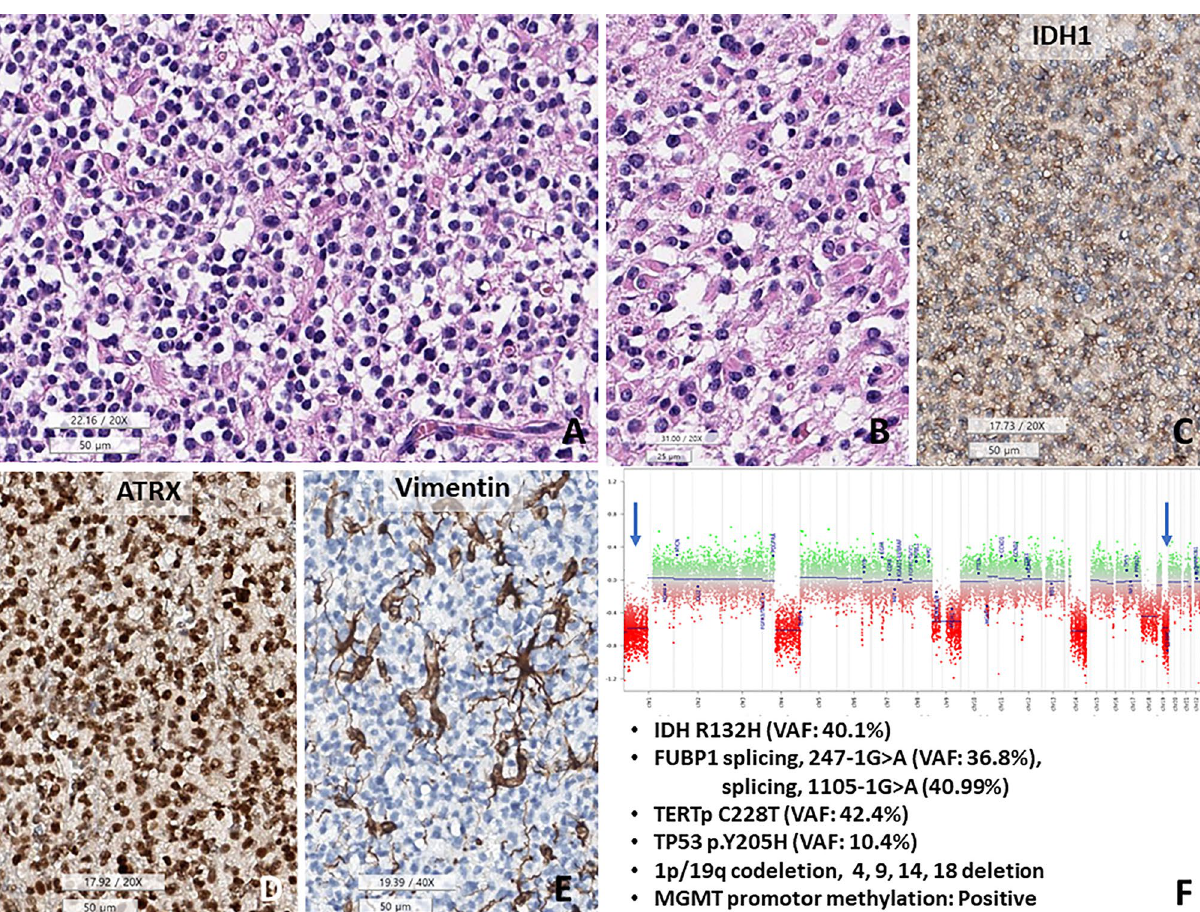
Figure 2. TP53 -mutant oligodendroglioma, CNS WHO grade 3. ( A ) The tumor shows fried egg-appearing monotonous rounded cells with fine capillaries. ( B ) Some tumor cells have eosinophilic cytoplasm,